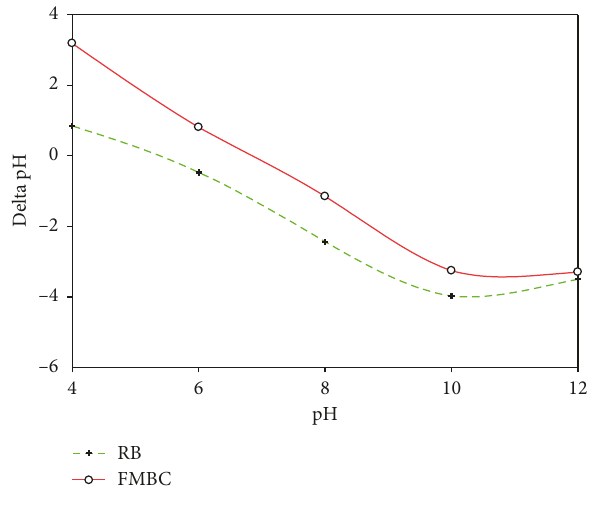
Figure 4: pH pzc of RB and FMBC.